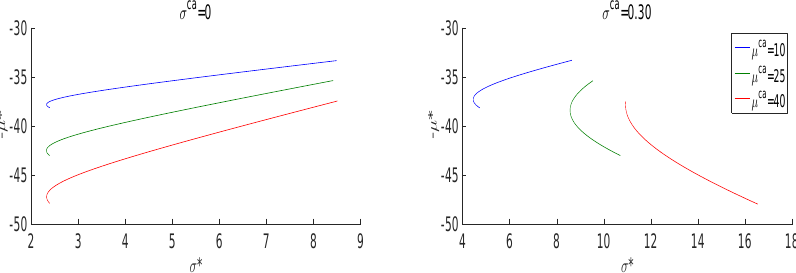
Figure 2. Systemic frontiers in the EEC mean-standard deviation plane ( − µ ∗ , σ ∗ ) under the two carbon volatility scenarios σ ca = 0 (left panel) and σ ca = 30% (right panel) for µ ca = 10, 25, 40.